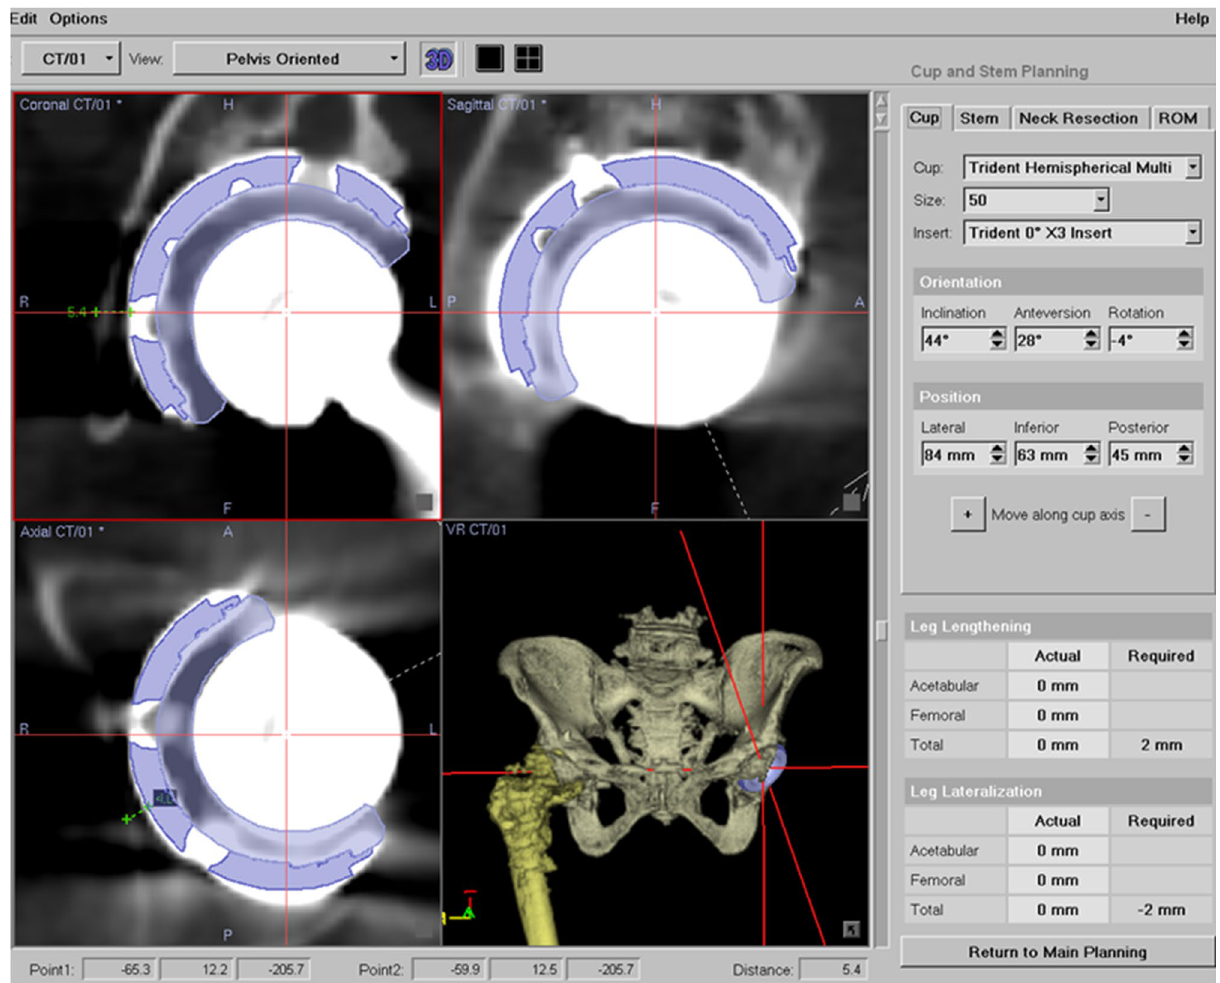
Figure 1. Acetabular cup angles are measured by superimposing the templates of the acetabular cup on postoperative images of the acetabular